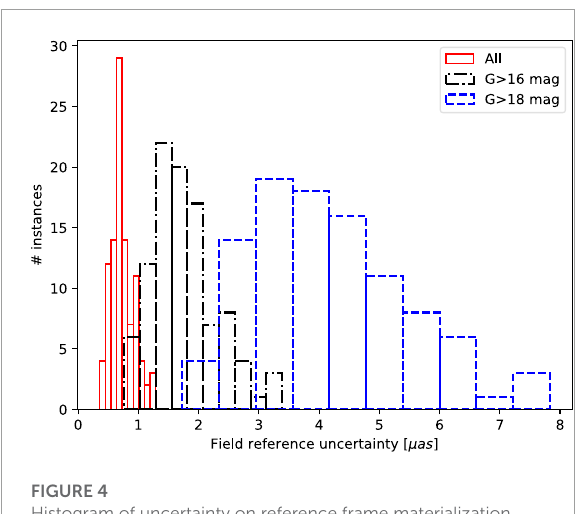
FIGURE 4 Histogram of uncertainty on reference frame materialization over the selected fields, using all stars (solid red line) or cutting to bright CSST-OS limiting magnitude G = 16 mag (black dashed-dotted line) and G = 18 mag (blue dashed